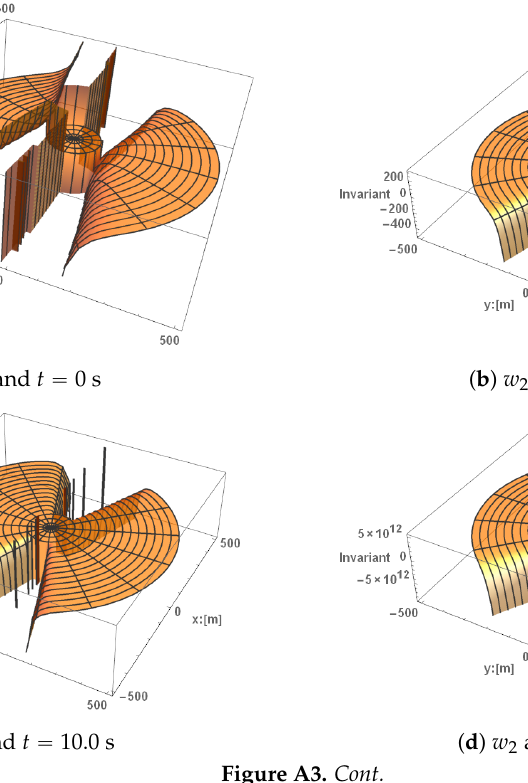
Figure A2. The time, t , of the invariant r 2 is plotted in the figures above. The other parameters were set to be σ “ 50,000 m ´ 1 , ρ “ 100 m, and a “ 1.0 m s ´ 2 . The plots were rendered using Mathematica’s ® RevolutionPlot3D. It plots a function by rotating the function around the z-axis. The amount that the space diverges from being flat is represented by the invariant function’s magnitude, and its amount is labeled on the vertical axis. The x and y-axis are displayed on the plots, and they display the distance from a spaceship in the flat portion at the center of each figure. Each radial line in the plot corresponds to a distance of approximately 33 m. The constant portion to the right of the harbor is to the front of the warp bubble, and the constant portion to the left of the harbor is the back of the warp